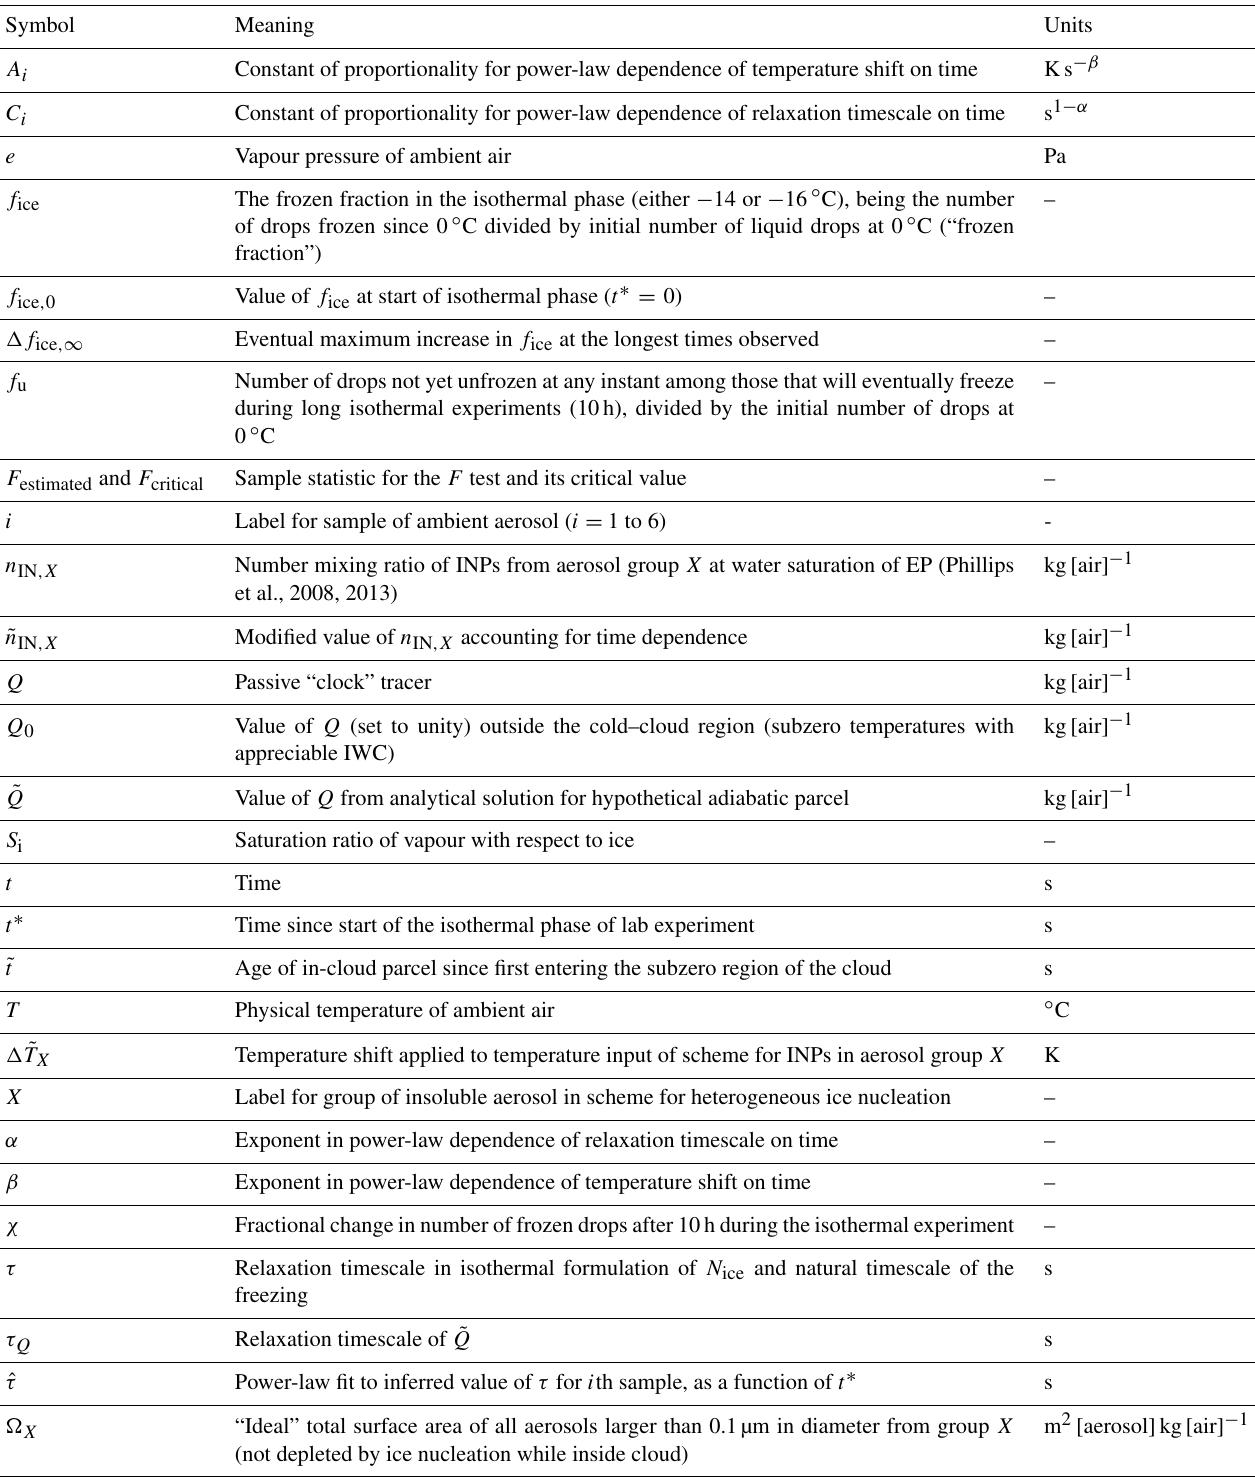
Table B1. List of